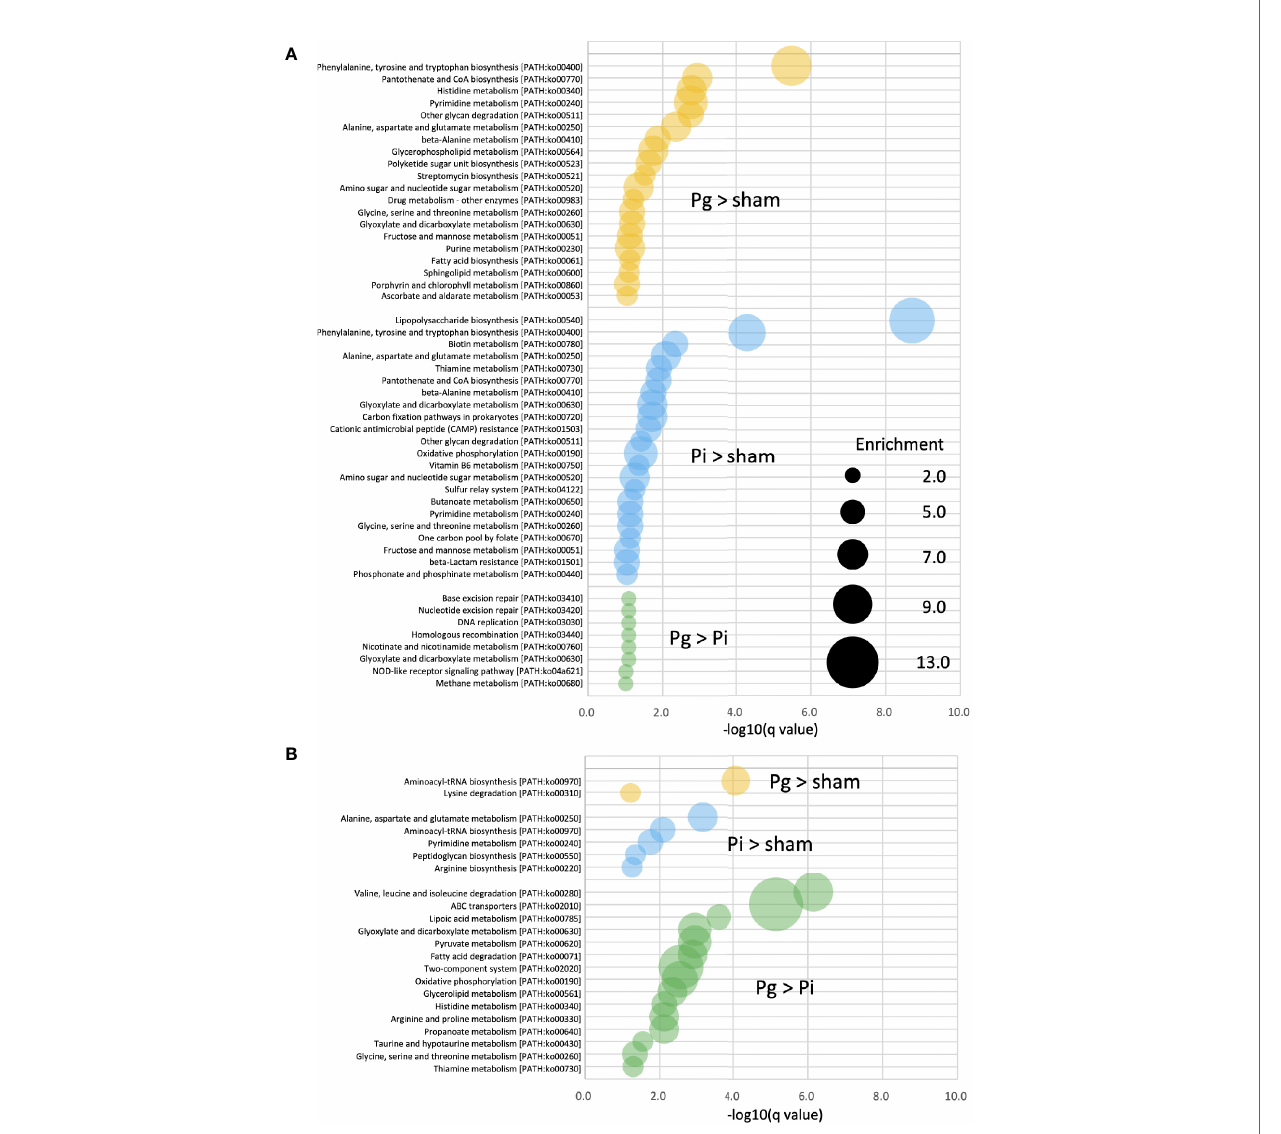
FIGURE 6 | KEGG biomarkers from the metagenomic analysis of gut microbiota. Pathway analysis of differentially enriched genes between two groups. Enriched KEGG pathways (q < 0.1) at TP2 (A) and TP3 (B) are shown. The bubble size indicates the number of KOs enriched in each pathway. Expressions containing inequality signs (e.g., “ Pg > Sham ” ) indicate that the results of enrichment analysis with Kos, in which the abundant of KOs for the left category ( Pg mice) are signi fi cantly more abundant than those in the right category (Sham